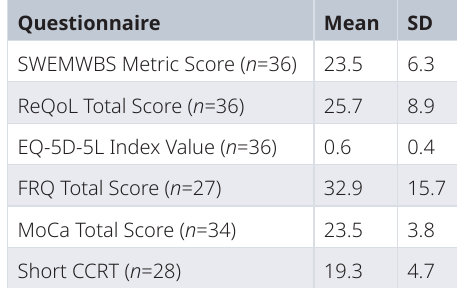
Table 5. Questionnaire scores of the